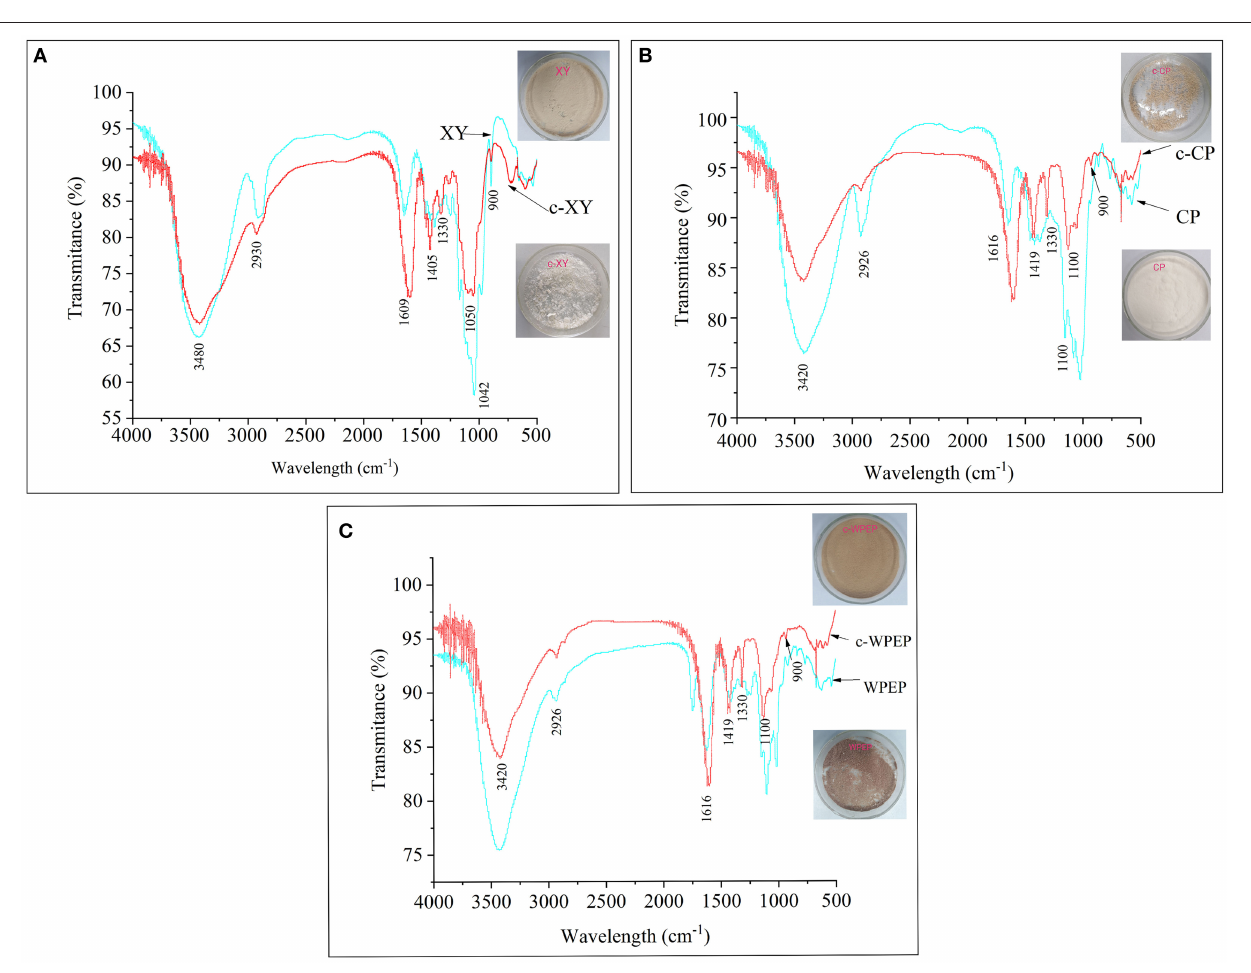
degree because the main polysaccharide in WPEP was